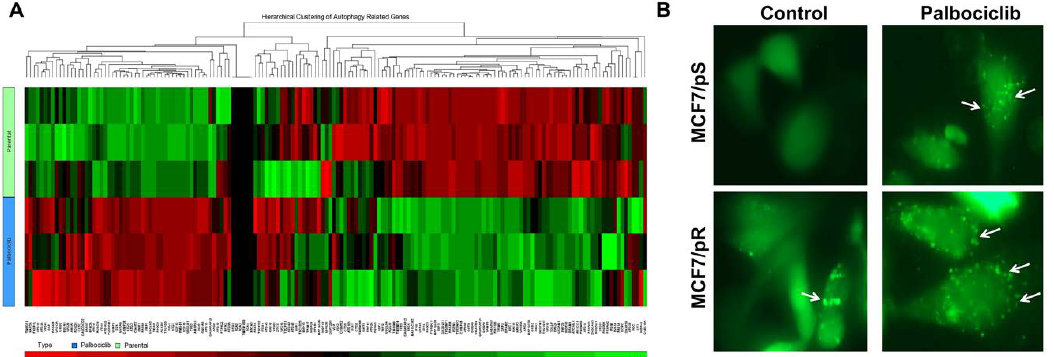
Figure 3. Increased autophagy is associated with palbociclib resistance in ER + MCF7 cells. ( A ) Hierarchical clustering of autophagy-related genes performed by MetaCore analysis. ( B ) Cells were transfected with a pEGFP-LC3 plasmid and treated with either vehicle control (0.5% water) or 500 nM palbociclib for 24 h. Formation of autophagosomes is depicted by punctate structures (arrows). Images were taken at 40× magnification with an EVOS microscope.